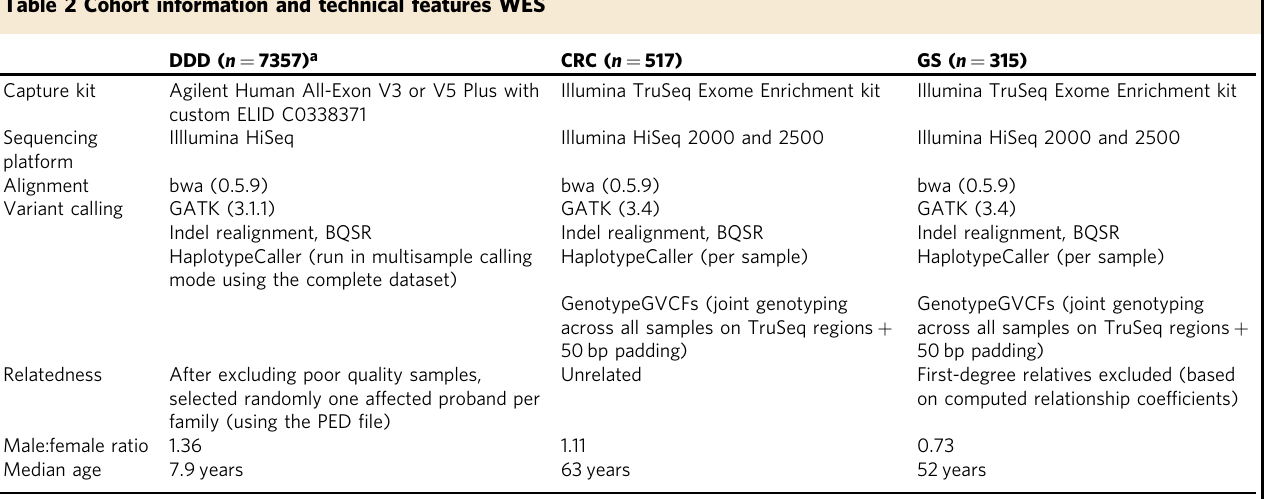
Table 2 Cohort information and technical features